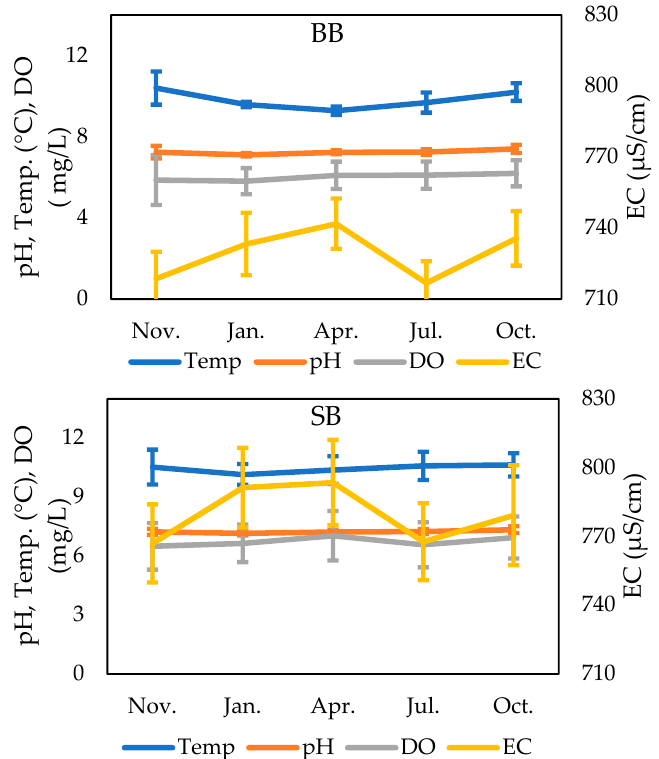
Figure 3. Temporal fluctuation of daily average physicochemical parameters of spring water (pH: brown line, Temp: blue line, DO: gray line, and EC: yellow line) in the study area from Nov. 2018 until Oct. 2019. Upper chart BB and lower chart SB; vertical error lines represent the ±SD of the respective parameter.